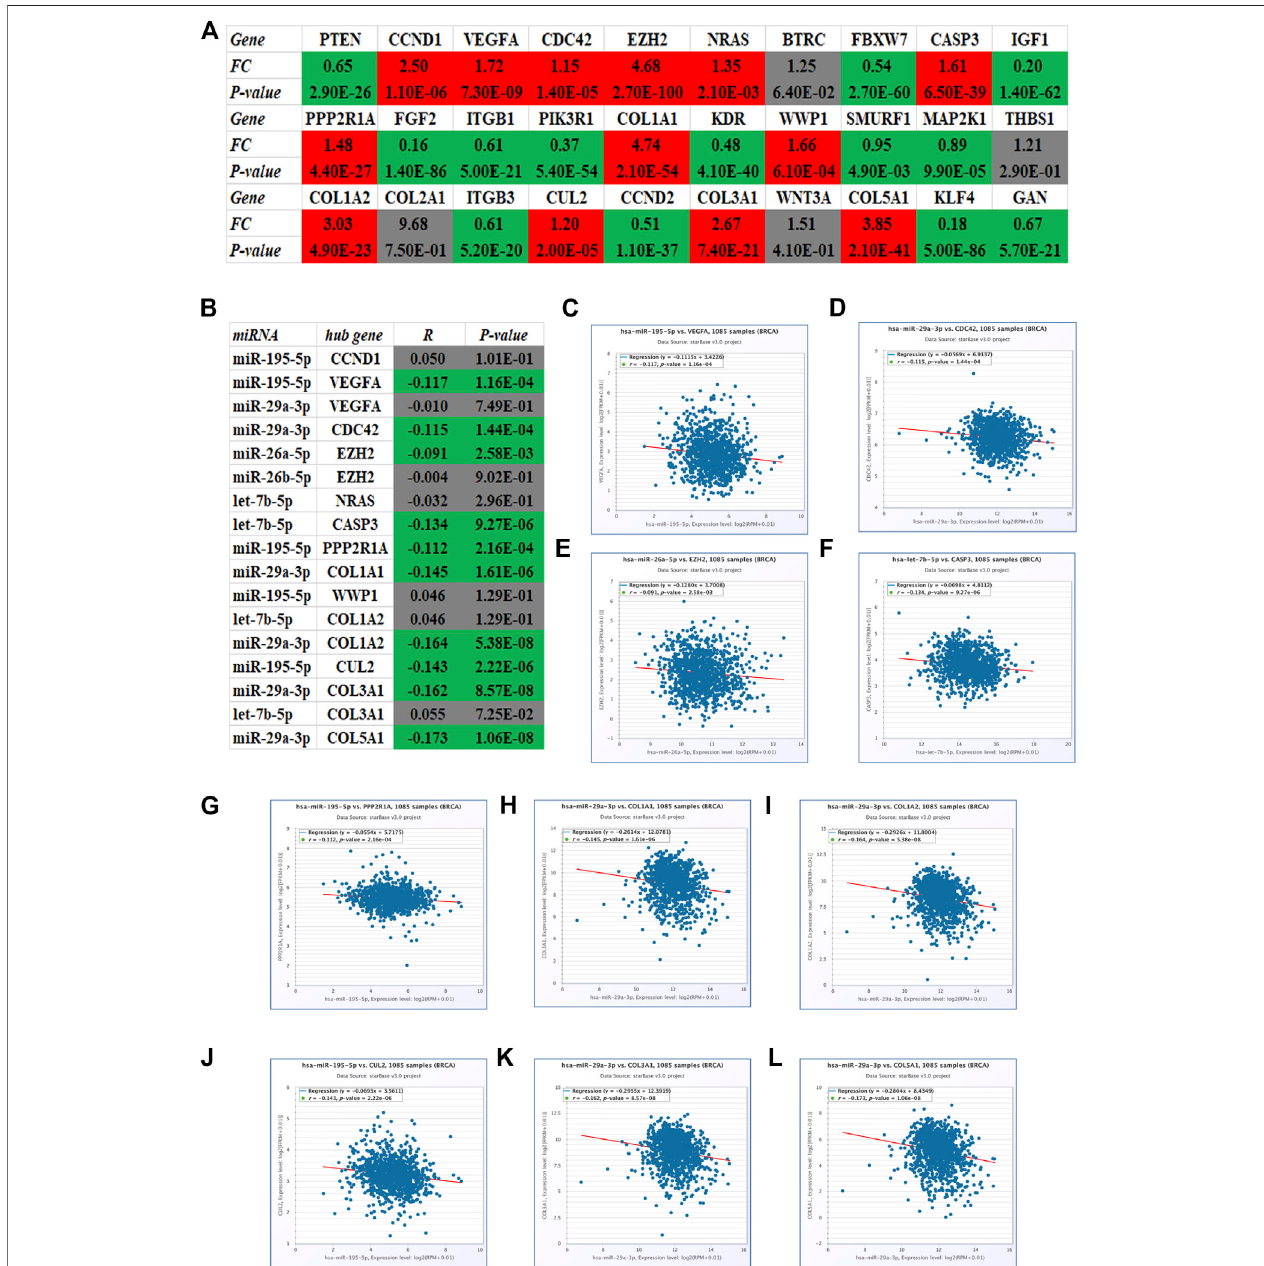
FIGURE 5 | Identi fi cation of potential target genes of fi ve miRNAs (let-7b-5p, miR-195-5p, miR-29a-3p, miR-26a-5p, and miR-26b-5p) in breast cancer using starBase. (A) Expression landscape of top 30 hub genes in breast cancer. (B) Correlation analysis for the candidate miRNA-hub gene pairs in breast cancer. The expression relationship of miR-195-5p/VEGFA (C) , miR-29a-3p/CDC42 (D) , miR-26a-5p/EZH2 (E) , let-7b-5p/CASP3 (F) , miR-195-5p/PPP2R1A (G) , miR-29a-3p/ COL1A1 (H) , miR-29a-3p/COL1A2 (I) , miR-195-5p/CUL2 (J) , miR-29a-3p/COL3A1 (K) , and miR-29a-3p/COL5A1 (L) pairs in breast cancer.